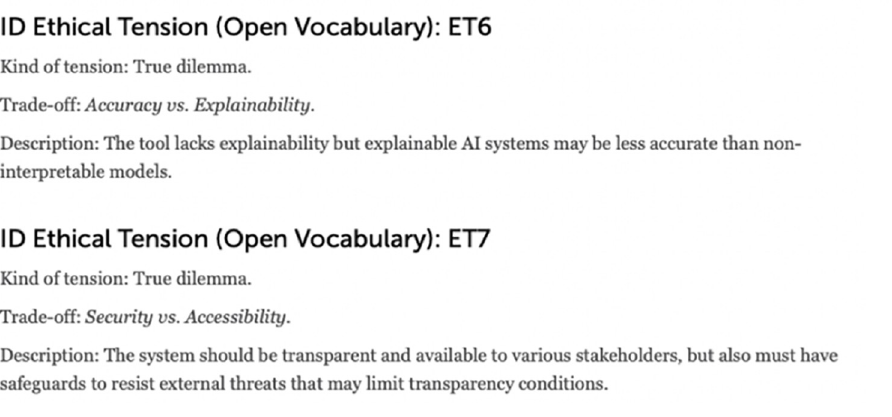
Fig 3. Ethical issue identified during the initial assessment of the use case